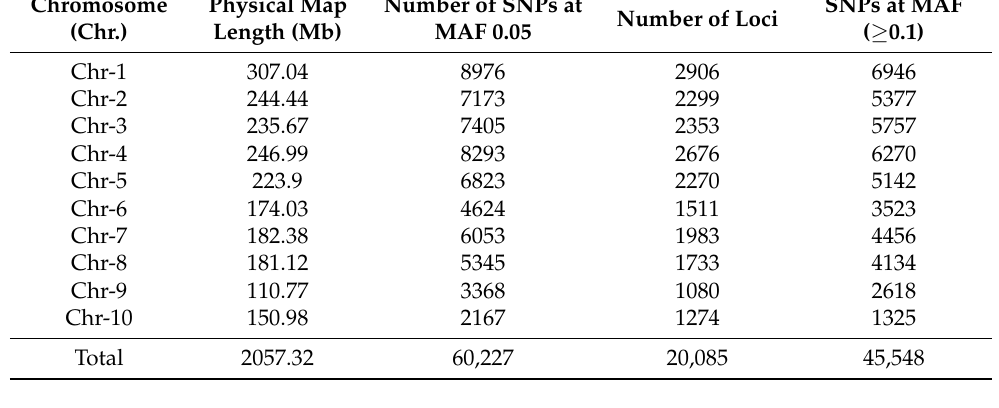
Table 1. Chromosome-wise distribution of the polymorphic SNPs at different minor allele frequencies (MAF), physicalmapping length, and different loci based on 384 diverse maize inbred lines. Chromosome